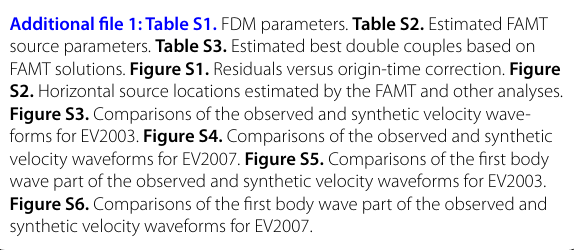
Figure S6. Comparisons of the first body wave part of the observed and synthetic velocity waveforms for